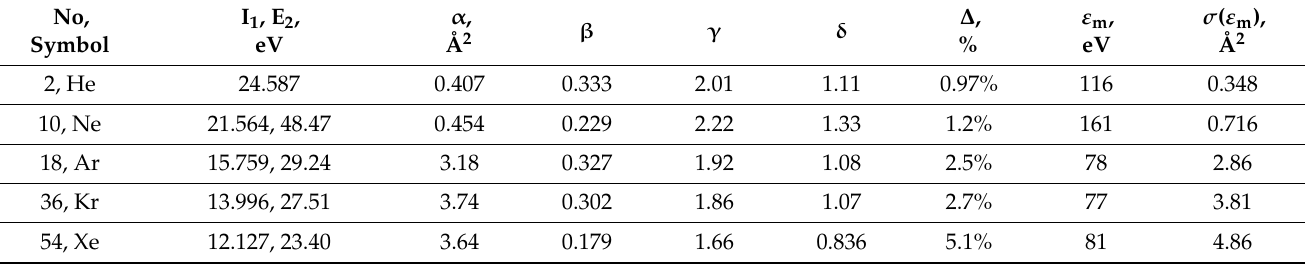
Table 3. Parameter values for approximating the ionization cross sections of noble gas atoms.